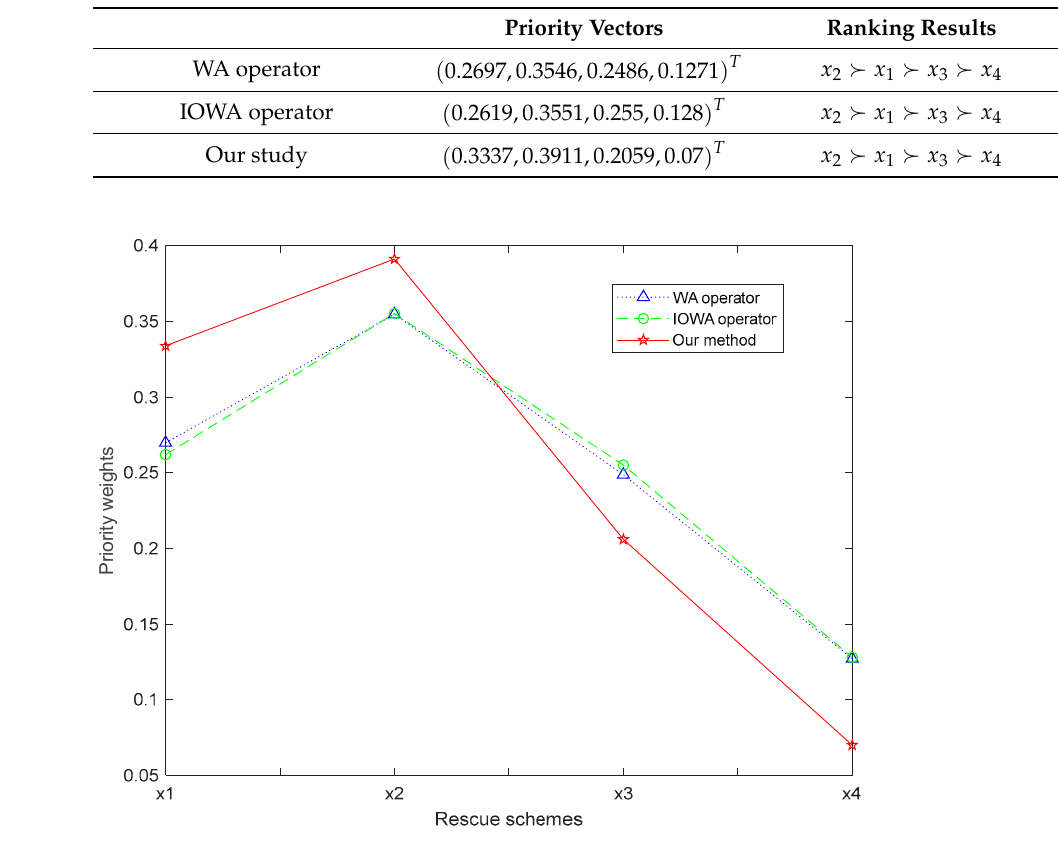
Table 5. Comparisons between the proposed method and the existing method.